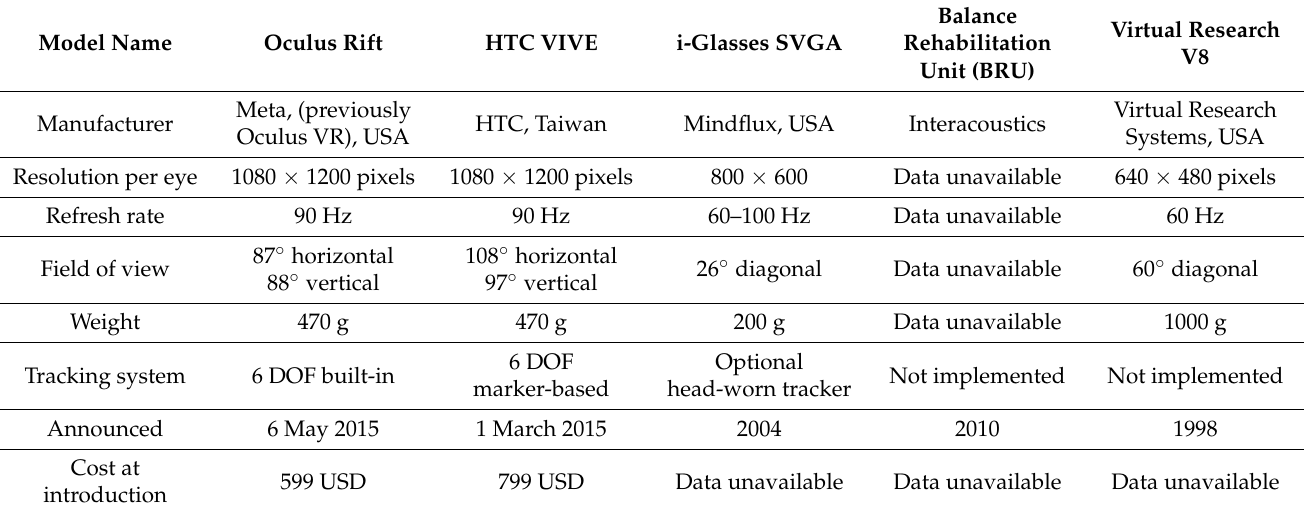
Table 2. Technical specifications of the head-mounted displays used in the studies included in this review. Based on specifications available in source manuscripts and producer brochures if available at time of